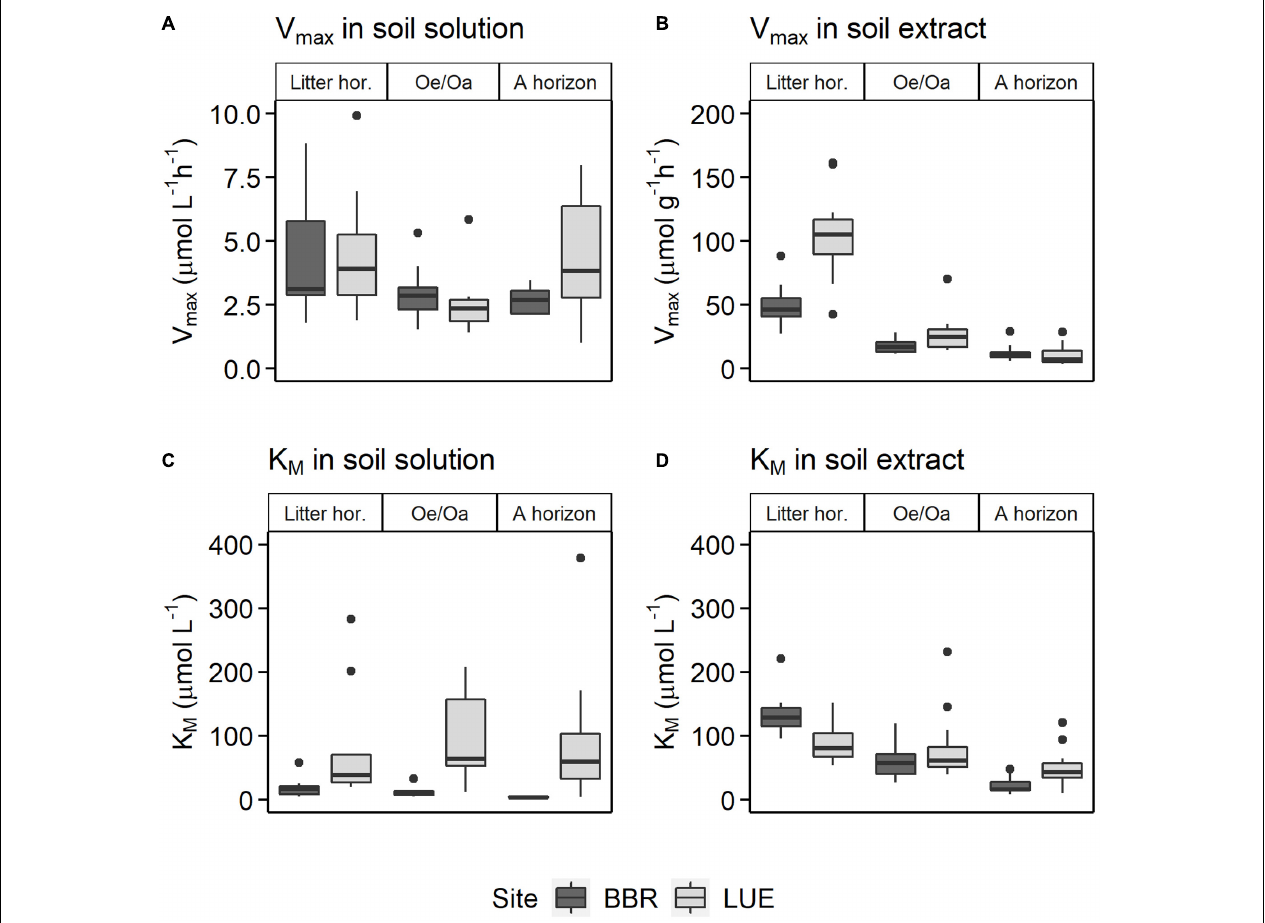
FIGURE 4 | Patterns of the Michaelis-Menten kinetic parameters (A,B) V max and (C,D) K M in (A,C) leached soil solutions and (B,D) soil extracts of litter, Oe/Oa, and A horizons at the P-rich site Bad Brückenau (BBR) and the P-poor site Lüss (LUE) averaged over fertilization treatments ( n = 12). Data from July